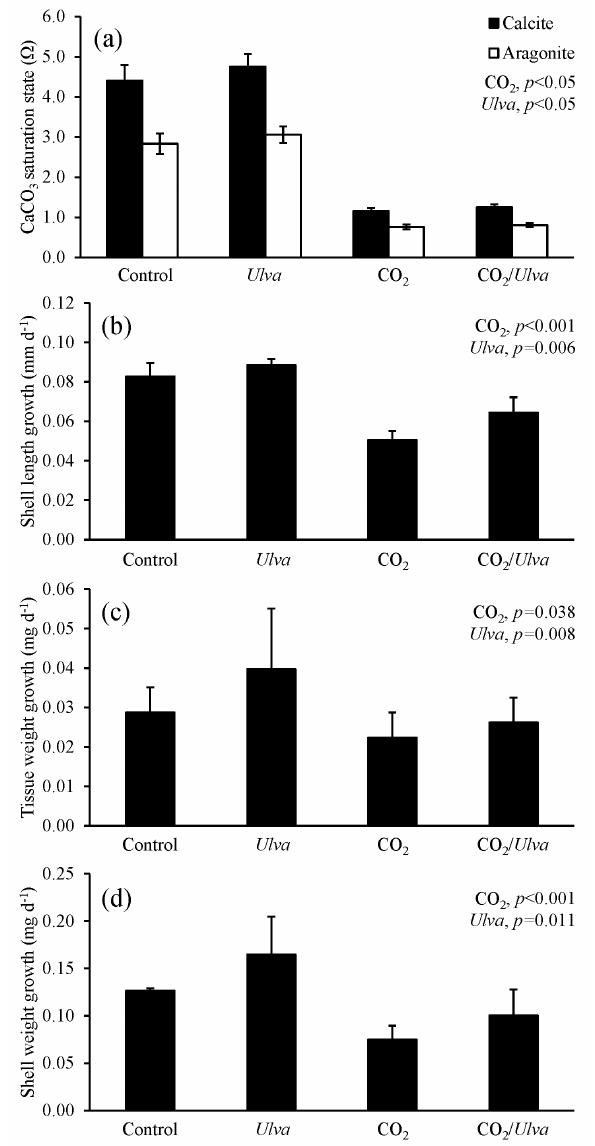
Figure 1. Experiment with small juvenile Mercenaria mercenaria exposed to ambient and elevated concentrations of CO 2 with and without the presence of Ulva . (a) (cid:127) calcite and (cid:127) aragonite ; growth was based on (b) shell length, (c) tissue weight, and (d) shell weight. Columns represent means ± standard deviation. Significant main treatment effects (CO 2 and Ulva ) appear at the top right of each